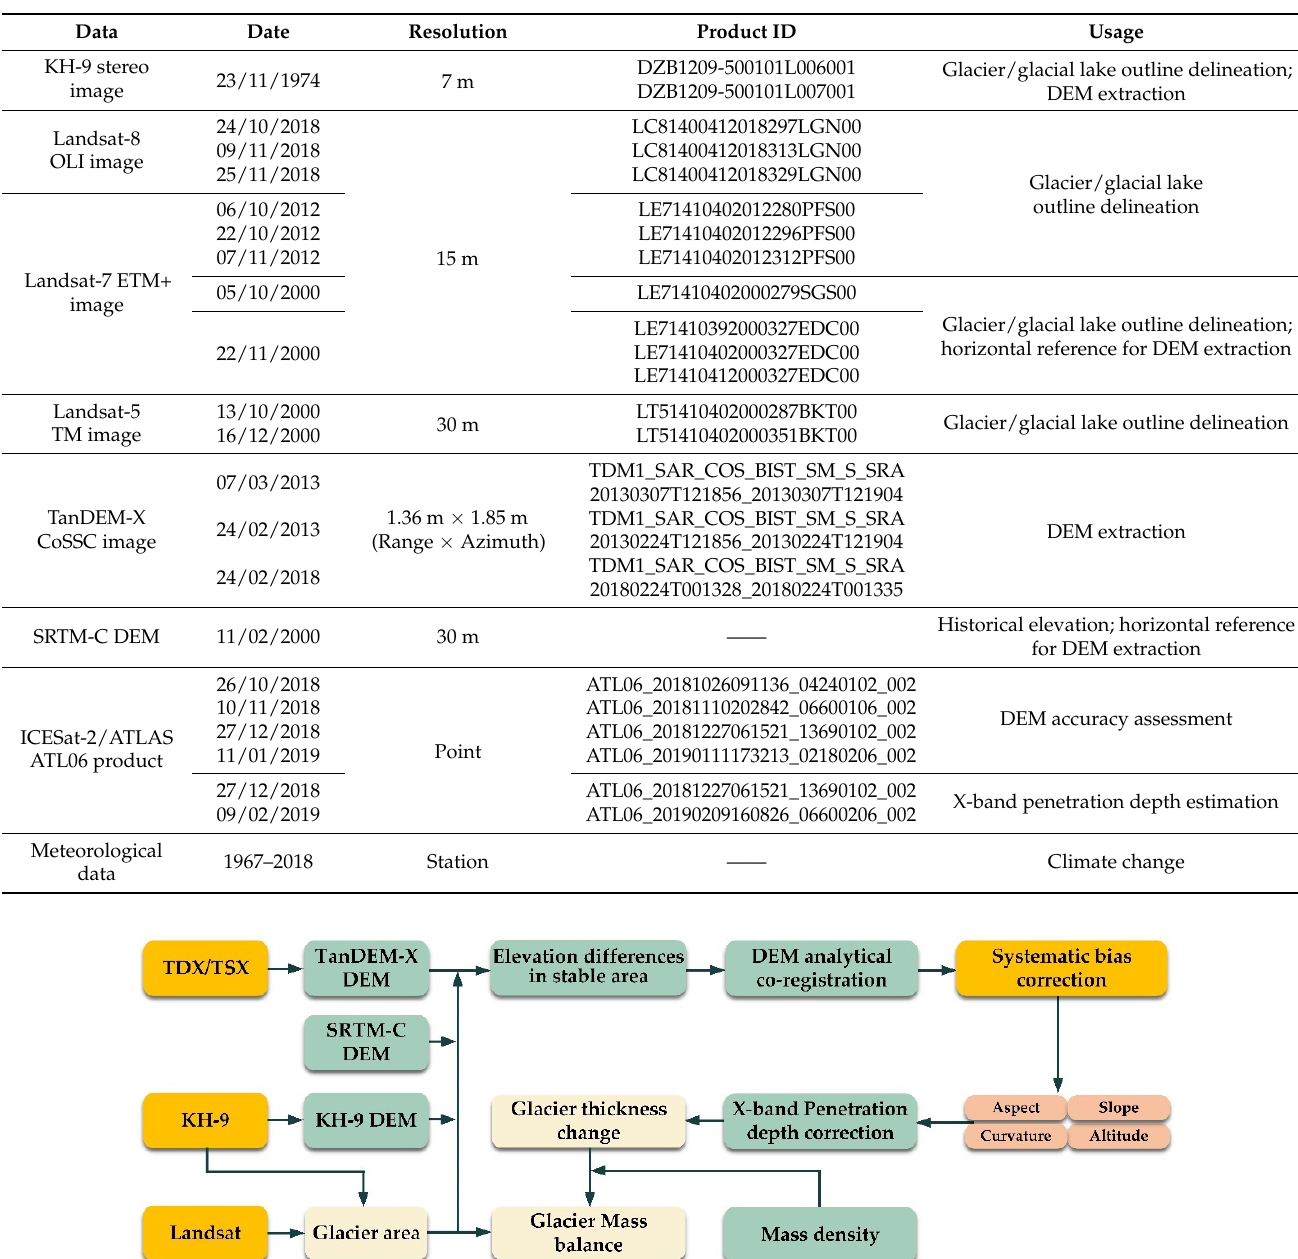
Table 2. Data used in this study.